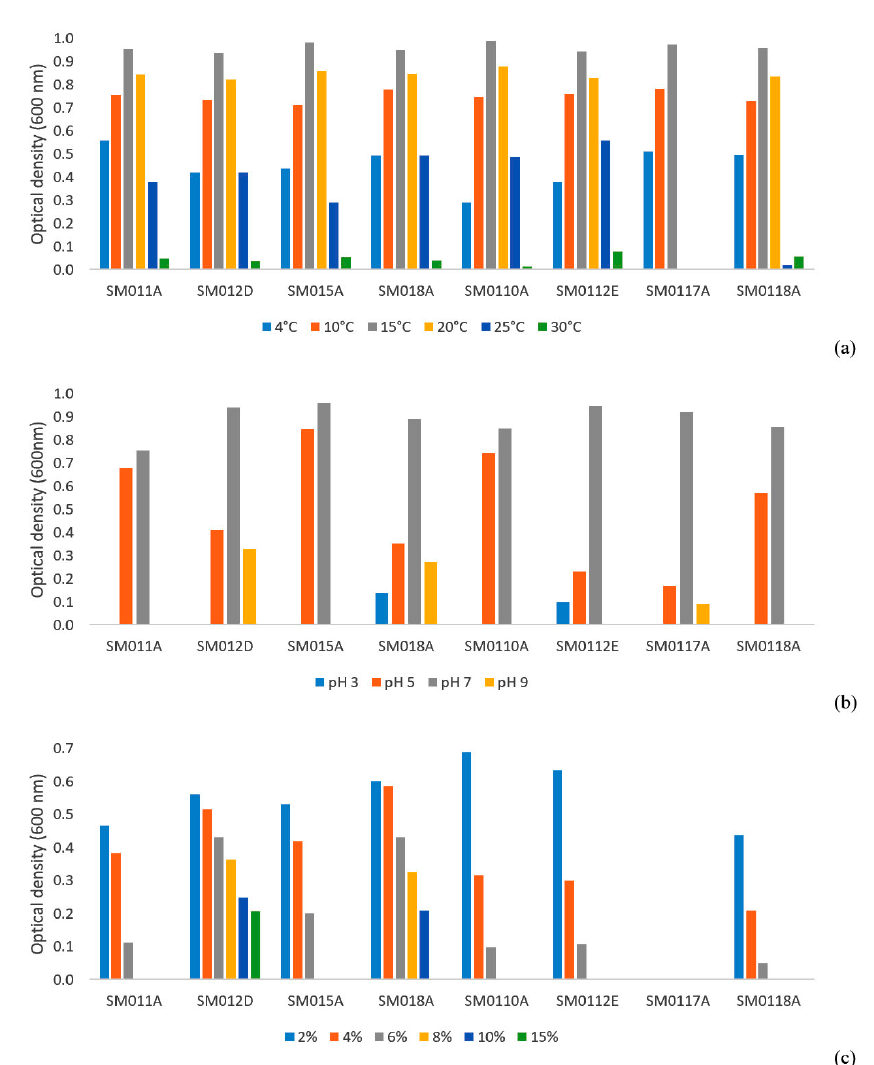
Fig. 3. Growth of cold-adaptive isolates according to different (a) temperature (b) pH and (c) salt (NaCl)